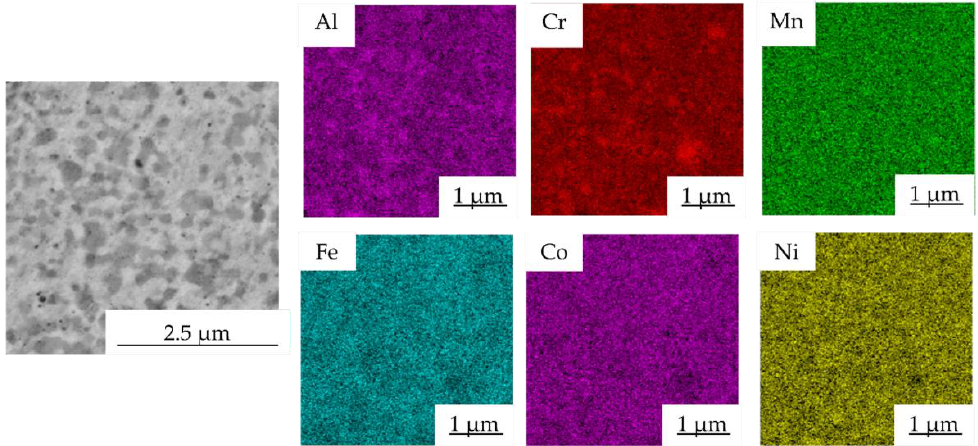
Figure 8. SEM + EDS map of element distribution in the Mn10Al10 MA + SPS compact alloy.